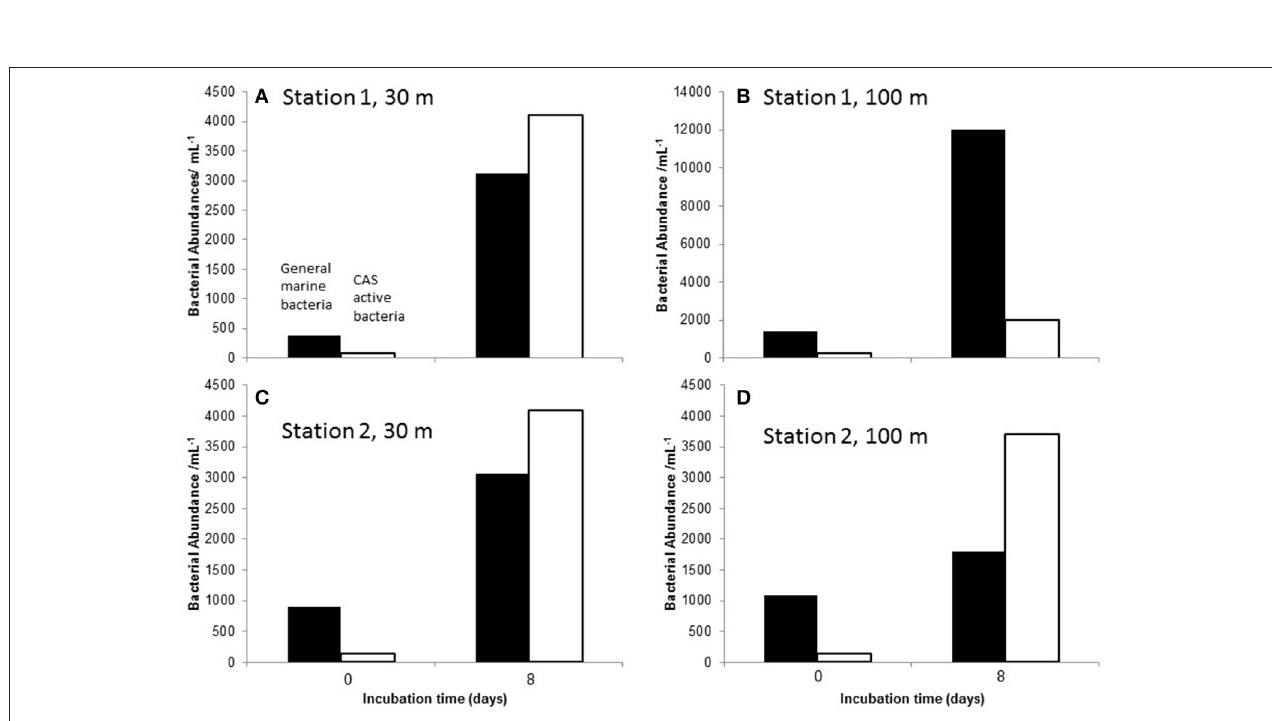
FIGURE 4 | The number of heterotrophic marine bacteria (MA, black bars) and CAS active bacteria (unfilled bar) at the start (day 0) and the end of incubation period [day 8, or day 7 station 1 (A,B) and station 2 (C,D) respectively]. Note different scale in (B) .